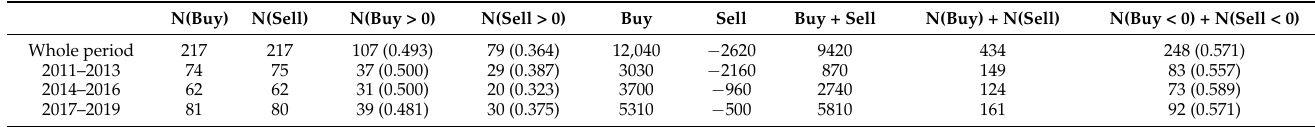
Table 2. The Performance of the Example MACD (4,22,3) Model.